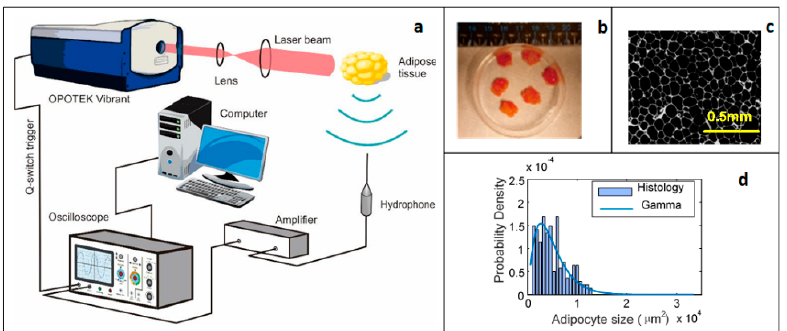
Figure 2. Experiment on ex vivo human adipose tissue specimens. ( a ) Schematic diagram of experimental setup for PA signal acquisition. ( b ) Photograph of human adipose tissue specimens. ( c ) Representative microphotograph of a human adipose tissue sample demonstrating adipocyte microarchitecture. ( d ) Adipocyte size distribution corresponding to ( c ).